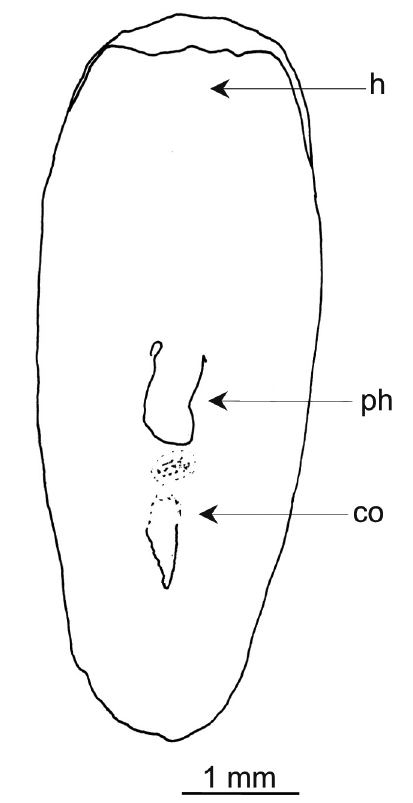
Fig. 2. Dendrocoelum obstinatum Stocchino & Sluys, sp. nov. Sketch of the ventral view of a preserved (Bouin’s fluid) specimen from